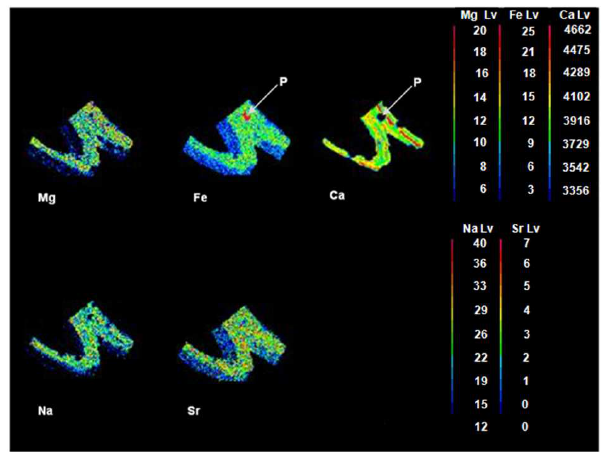
Fig. 8. Cross section of a Bolivina spissa specimen from 640 m water depth (M77-1-565/MUC-60) with a secondary electron overview image in the middle. Close ups of sections of Ca-EMP mappings (Ca) secondary electron images (SE) and backscattered electron images (BSE) are shown. Note that the Ca distribution is reflected by the holey structures seen on the BSE